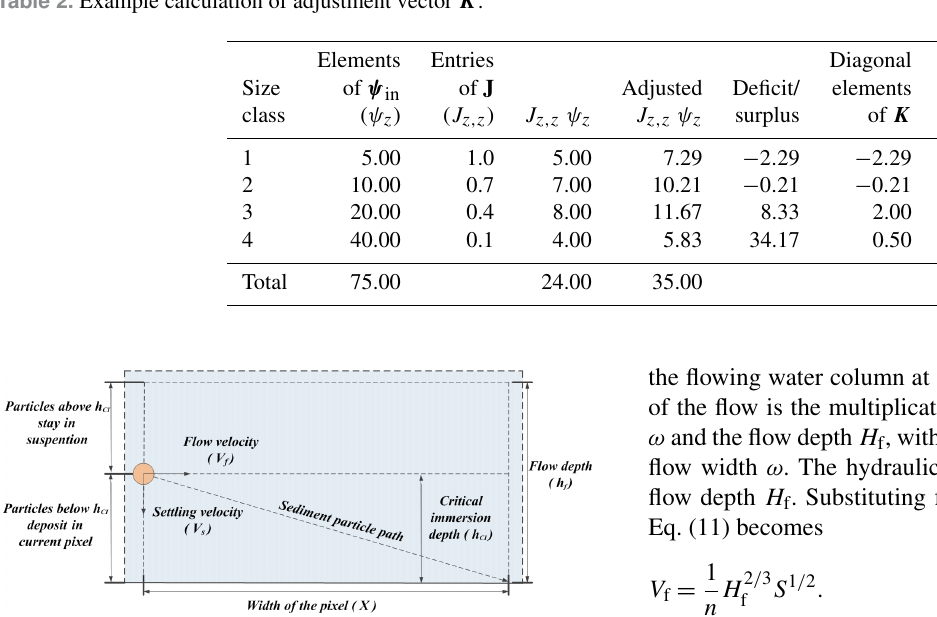
Table 2. Example calculation of adjustment vector K .